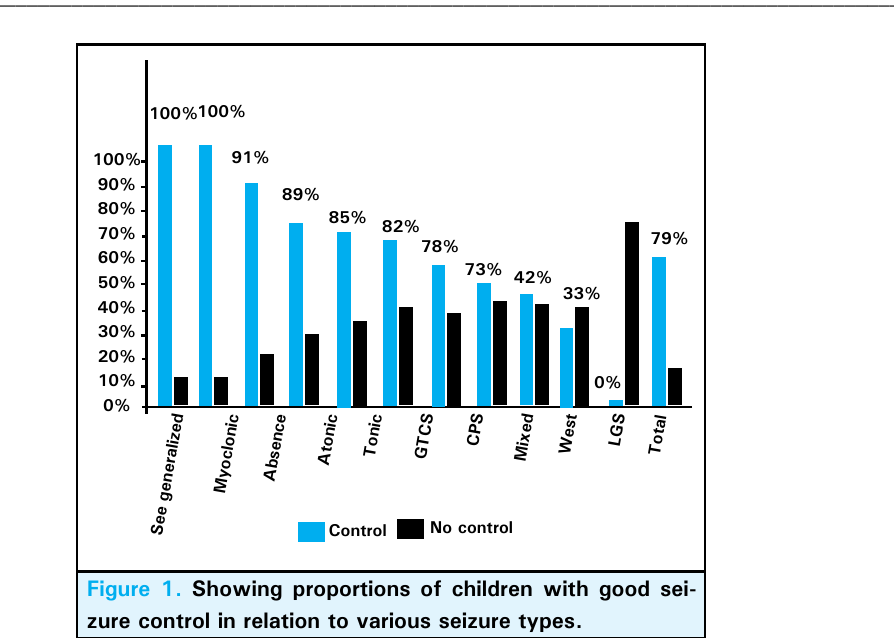
Figure 1. Showing proportions of children with good sei- zure control in relation to various seizure